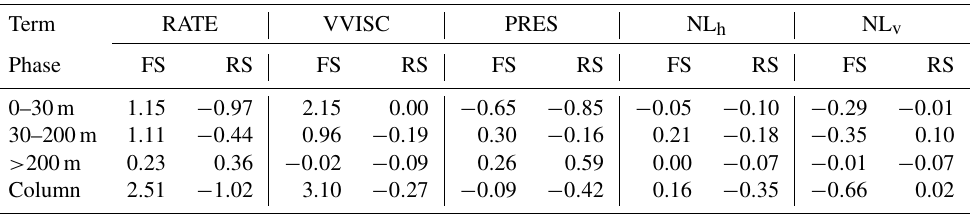
Table 1. Time integrated KEni budget (unit: × 10 3 Jm − 2 ) during the FS and